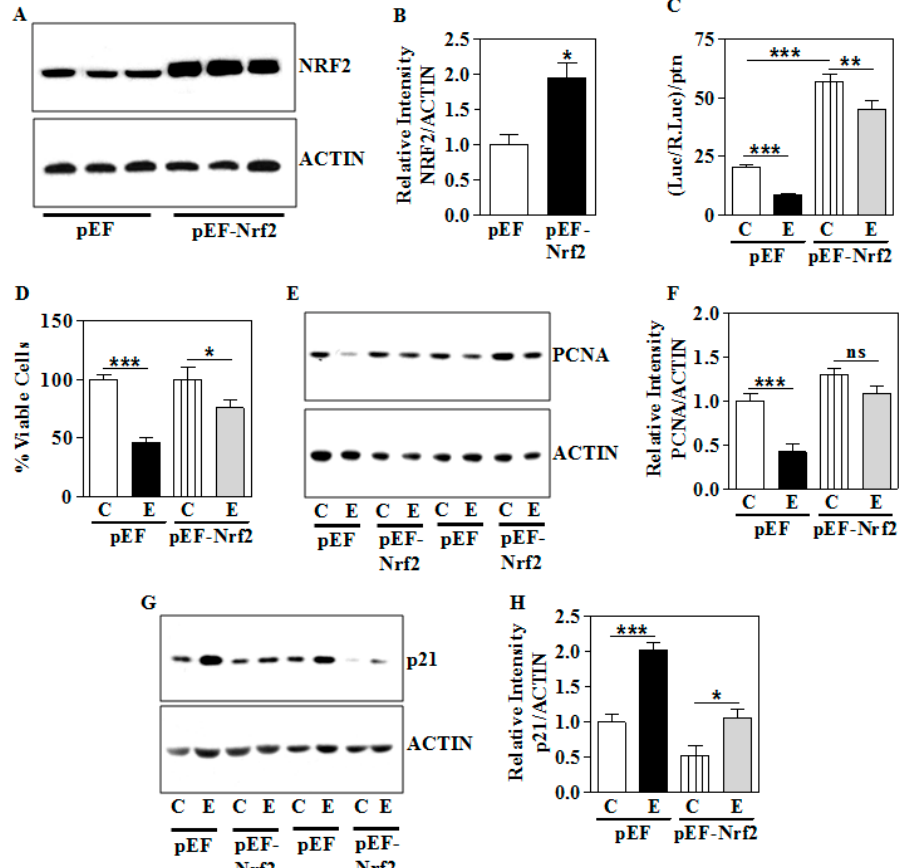
Figure 8. Effect of overexpression of Nrf2 on the E-induced dysregulation of NRF2,